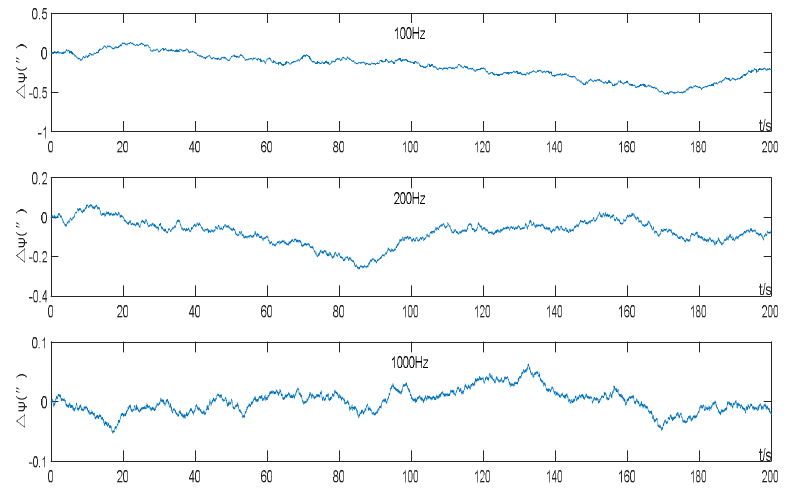
Figure 4. Heading error of the simulation test with different sampling frequencies.